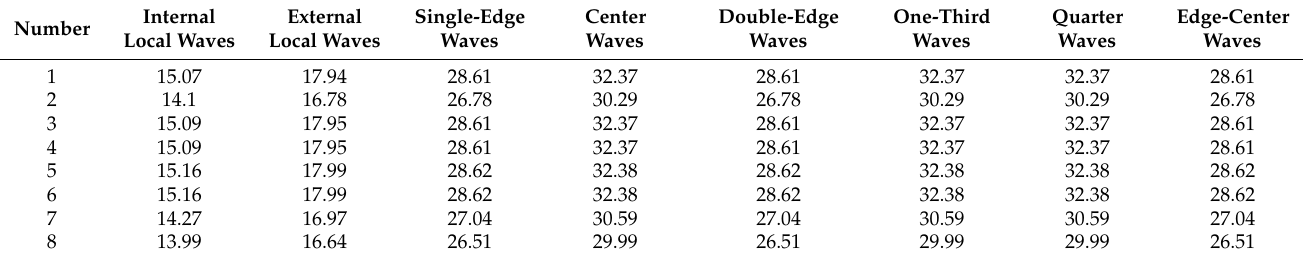
Table 3. Quality conformity thresholds for all flatness defects